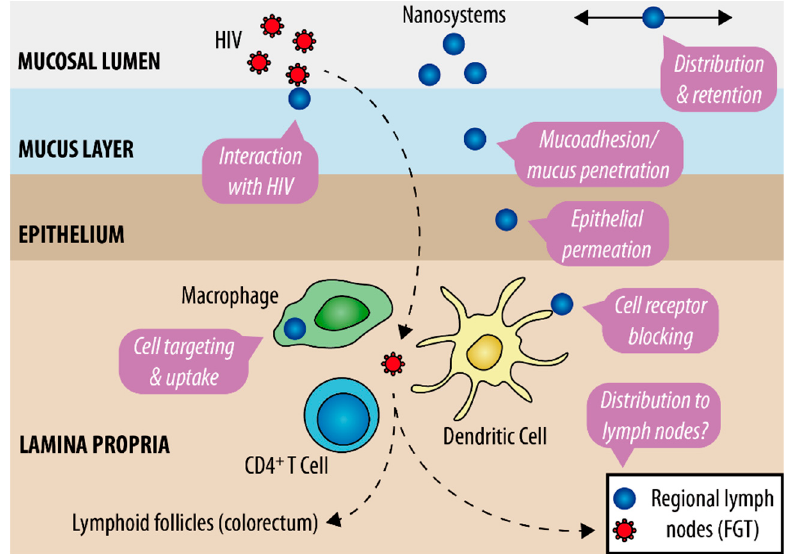
Figure 1. The potential of nanotechnology-based systems for microbicide development. Features of anti-HIV microbicide nanosystems at cervicovaginal or colorectal mucosal sites in the context of sexual HIV transmission are indicated in pink call-outs (see text for more details). FGT—female genital tract.